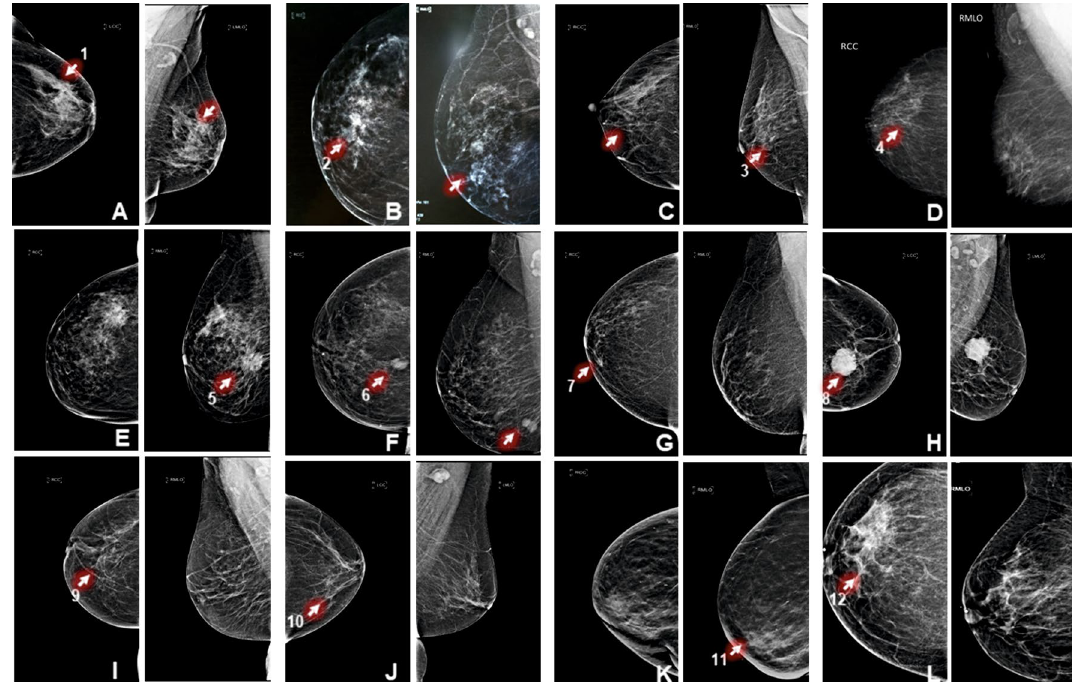
Figure 2. Medio-lateral oblique and cranio-caudal mammography images of patients recruited in the discovery phase of the study. ( A )–( J ) shows features of early invasive breast cancer and K-L shows features of benign breast tumor. (1) focal architectural disruption; (2) speculated mass; (3) micro-calcification; (4) micro-calcification along with subtle focal asymmetry; (5) multiple speculated masses; (6) macro-lobulated mass; (7) subtle area of focal architectural distortion; (8) circumscribed mass with focal speculation; (9) architectural distortion; (10) unilateral axillary lymphadenopathy; (11) well circumscribed masses; (12) fat containing